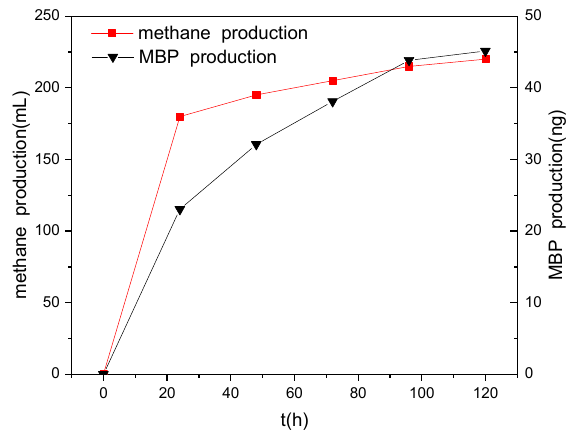
Figure 6. Changes in the production of biogas and MBP over time.